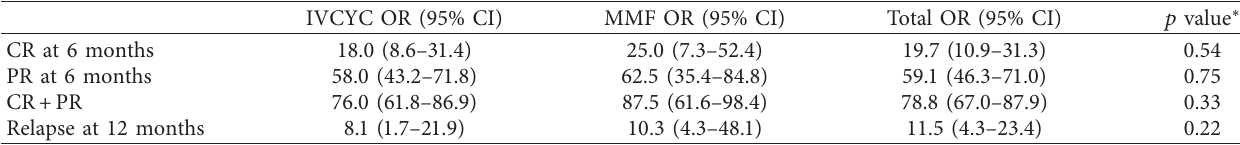
Table 3: : Complete, partial remission and relapse in the two groups after